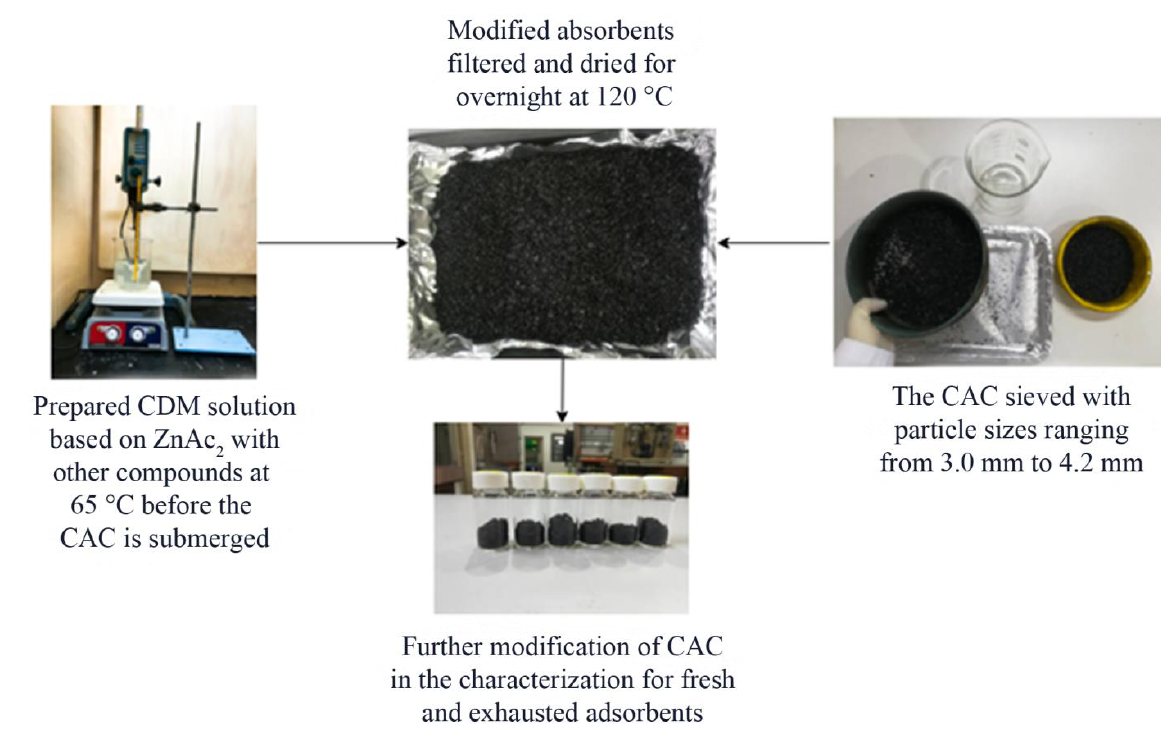
Figure 7. Adsorbent preparation steps. Table 5. Description of prepared adsorbents.